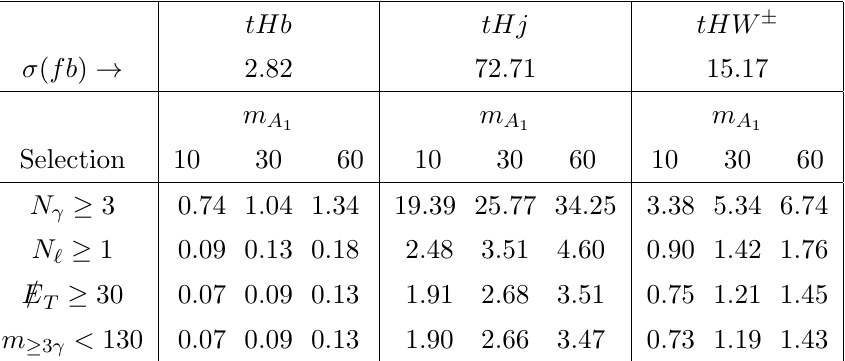
Table 4 . Same as table 3, but for tH process.